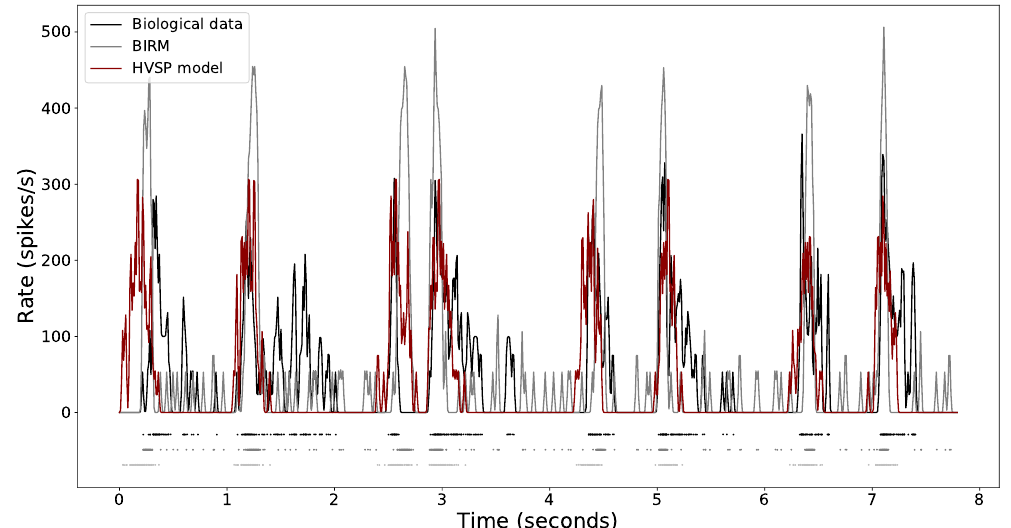
Figure 10. Spike rasters and normalised PSTHs of one retinal ganglion cell responding to 4 repeated trials of the same selected stimulus: biological data (black), tuned bioinspired retinal model (BIRM) (grey) and the Poisson spike generator (HVSP) model